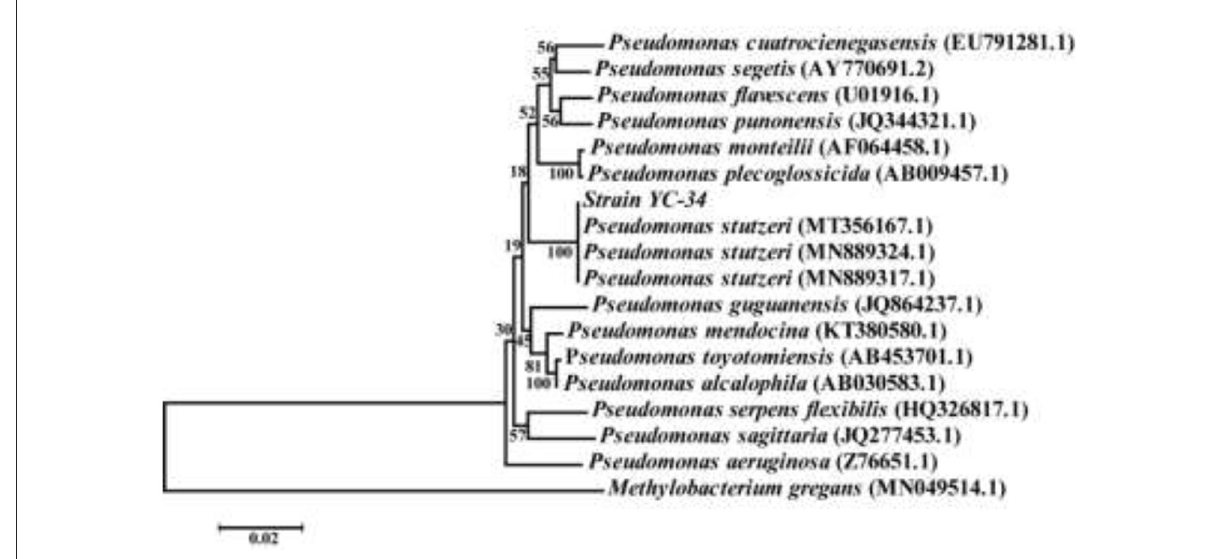
FIGURE1 The phylogenetic tree of Pseudomonas stutzeri strain YC-34 and related